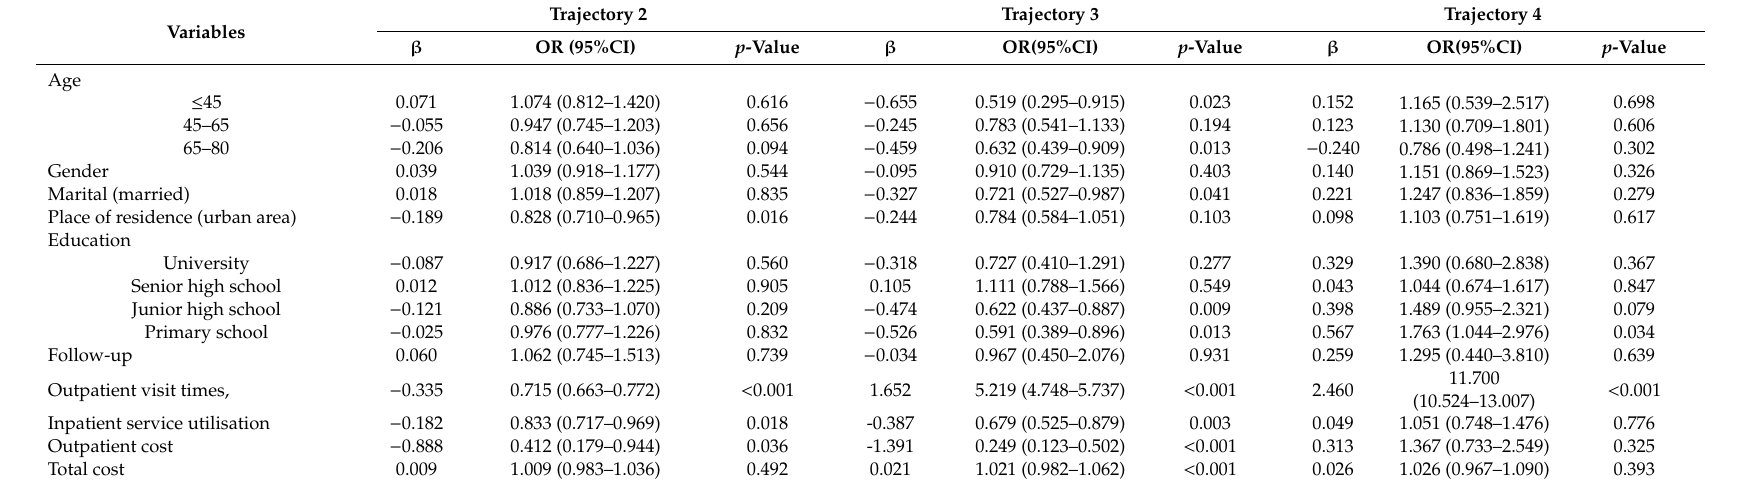
Table 3. Multinomial logistic regression analysis in outpatient service utilisation trajectory